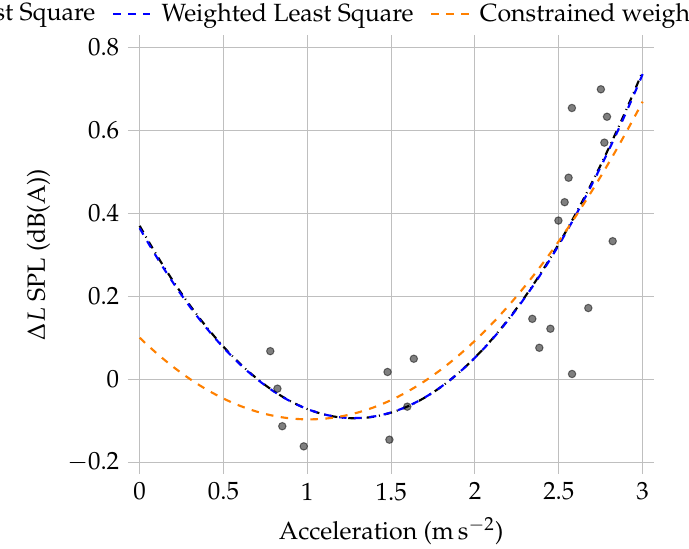
Figure 4. Impact of different regression algorithms for the measurement of 255P mounted on LSBEV driven with FWD and MB-Correction (Section 5.1)